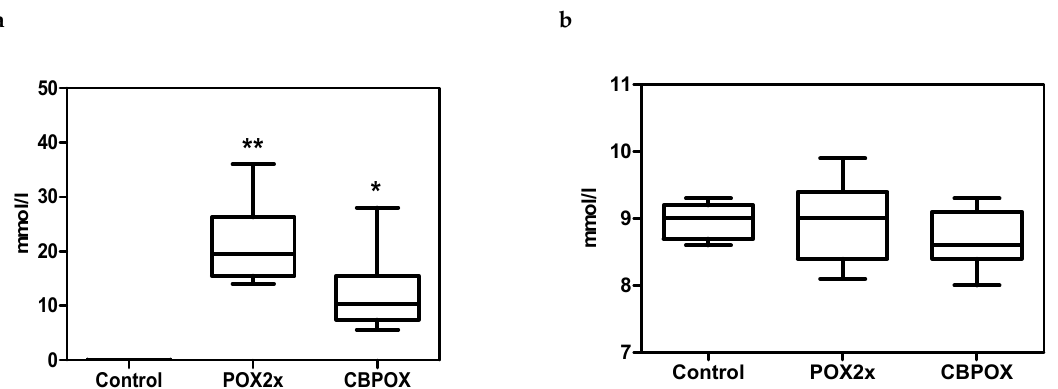
Figure 2. Glucose content 24 h after poisoning: ( a ) in rat urine; ( b ) in rat plasma. * p ≤ 0.05; ** p ≤ 0.01 compared to the control group.